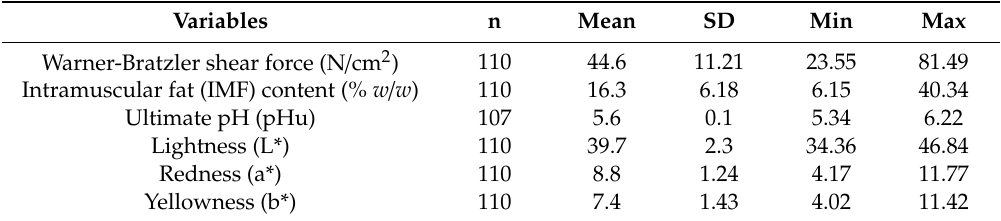
Table 4. Descriptive statistics of the 6 variables from the meat level corresponding to meat quality traits measured in Longissimus thoracis